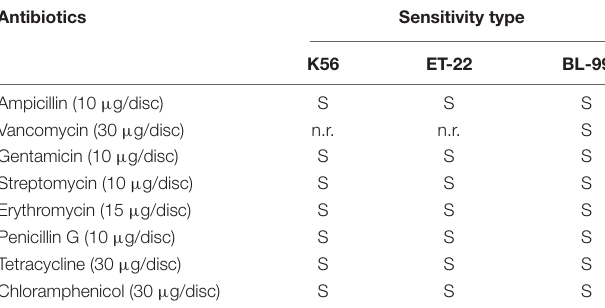
TABLE 2 | Results of antibiotic susceptibility testing by disc diffusion